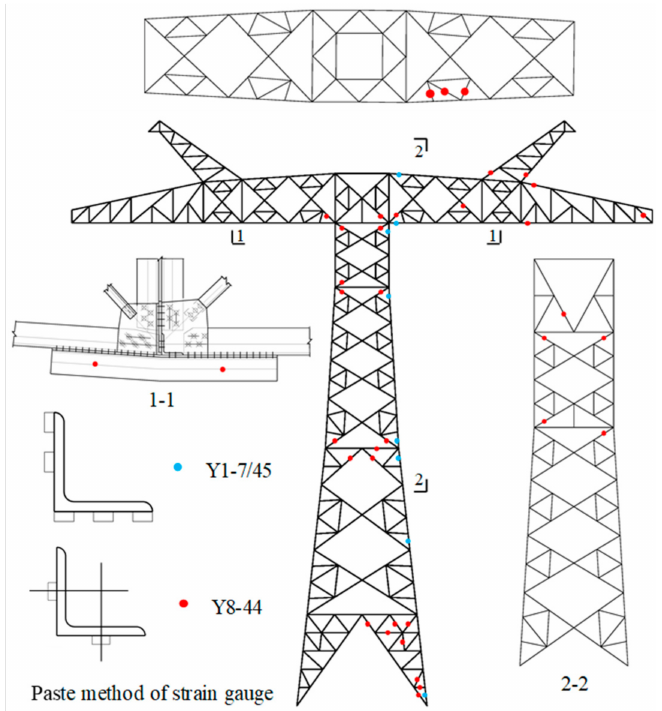
Figure 4. Layout of strain